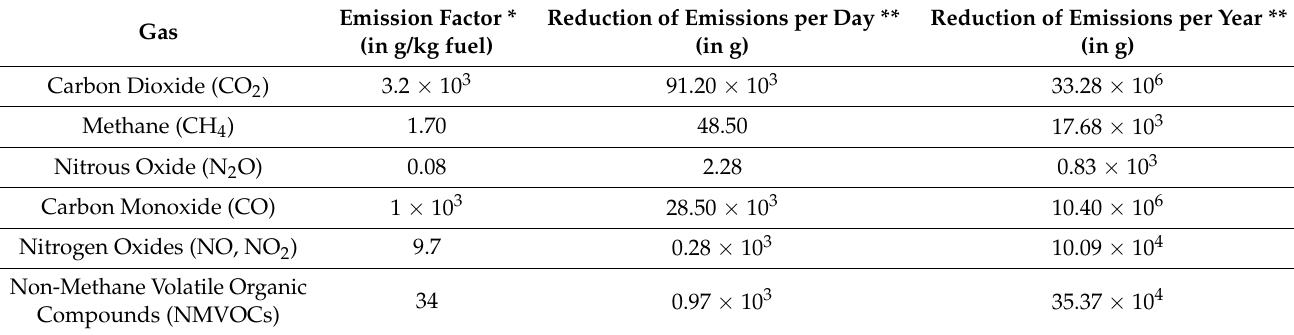
Table 1. Possible reduction in gas emissions by the optimized school